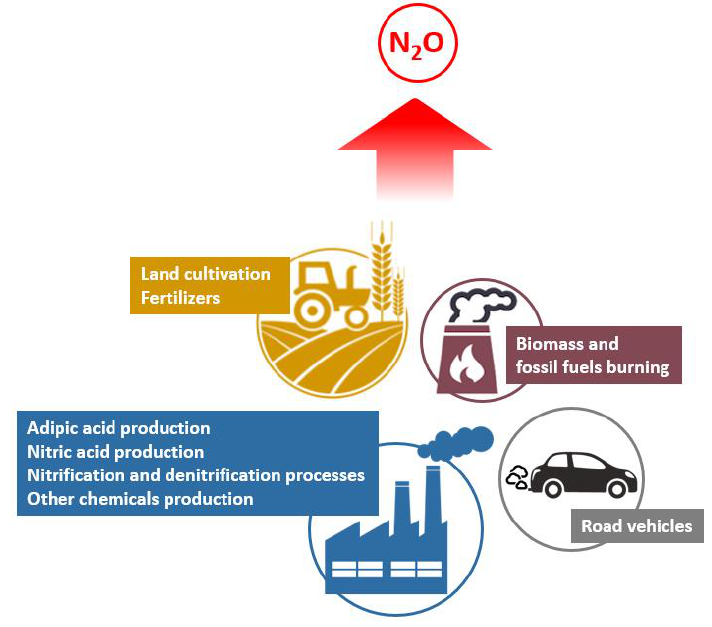
Figure 1. Main anthropogenic sources of N 2 O. The different contributions of the anthropogenic sources of N 2 O are reported in Figure 2.